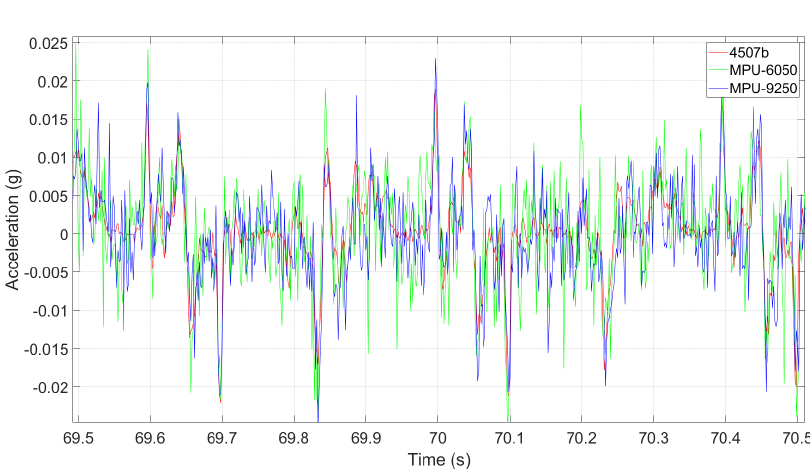
Figure 11. Responses in the time domain using the modulated shaker at 2,5 Hz/0,02g.